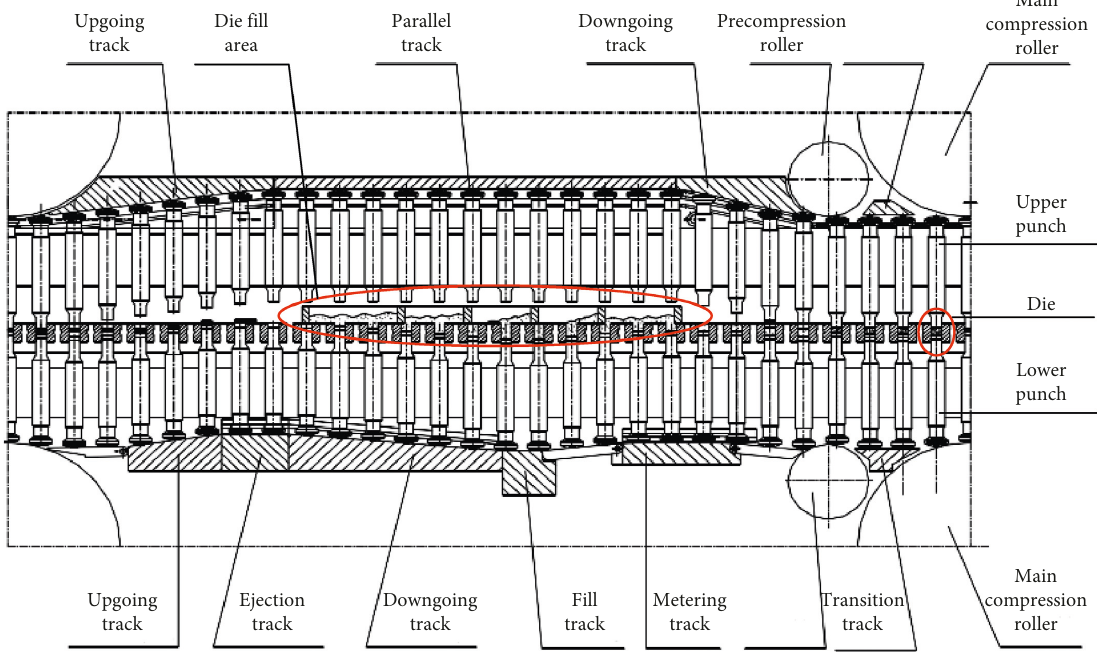
Figure 3: Schematic diagram of unfolded view of a rotary tablet press.